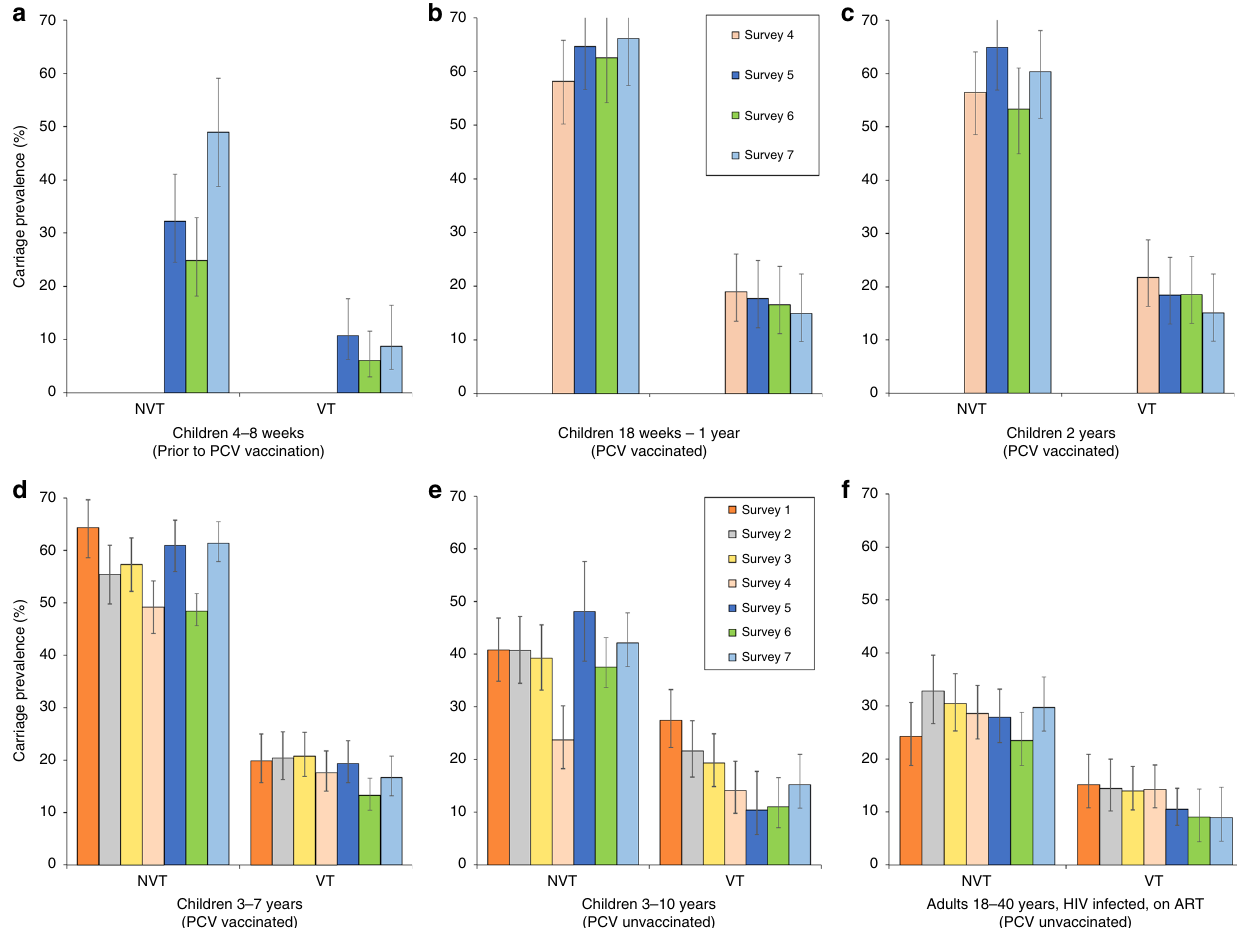
Fig. 2 S. pneumoniae carriage prevalence per survey, strati fi ed by study group. Surveys 1 – 7 spanned a time of 3.6 – 7.1 years after the 12 November 2011 introduction of PCV into Malawi ’ s EPI program. Younger children (4 – 8 weeks up to 2 years of age; cells a – c ) were recruited starting survey 4 or 5. Prevalence of non-carriers is calculated by 1 − (NVT + VT). Aggregated sample size for each study group: a n = 346 children 4 – 8 weeks old (PCV- unvaccinated), b n = 566 children 18 weeks to 1 year old (PCV vaccinated), c n = 499 children 2 years old (PCV vaccinated), d n = 2565 children 3 – 7 years Supplementary Tables 3 and 4 for the sample sizes used in calculating per-survey VT and NVT prevalence data and error bars in this fi gure. 95% con fi dence interval error bars are shown. The con fi dence interval bounds are calculated by exponentiating the bounds in the logit